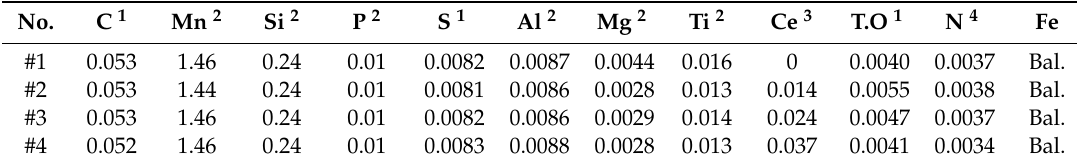
Figure 1. Schematic diagram of the order of adding alloys, sampling time and cooling processes. Table 1. Chemical composition of tested steels/wt%.